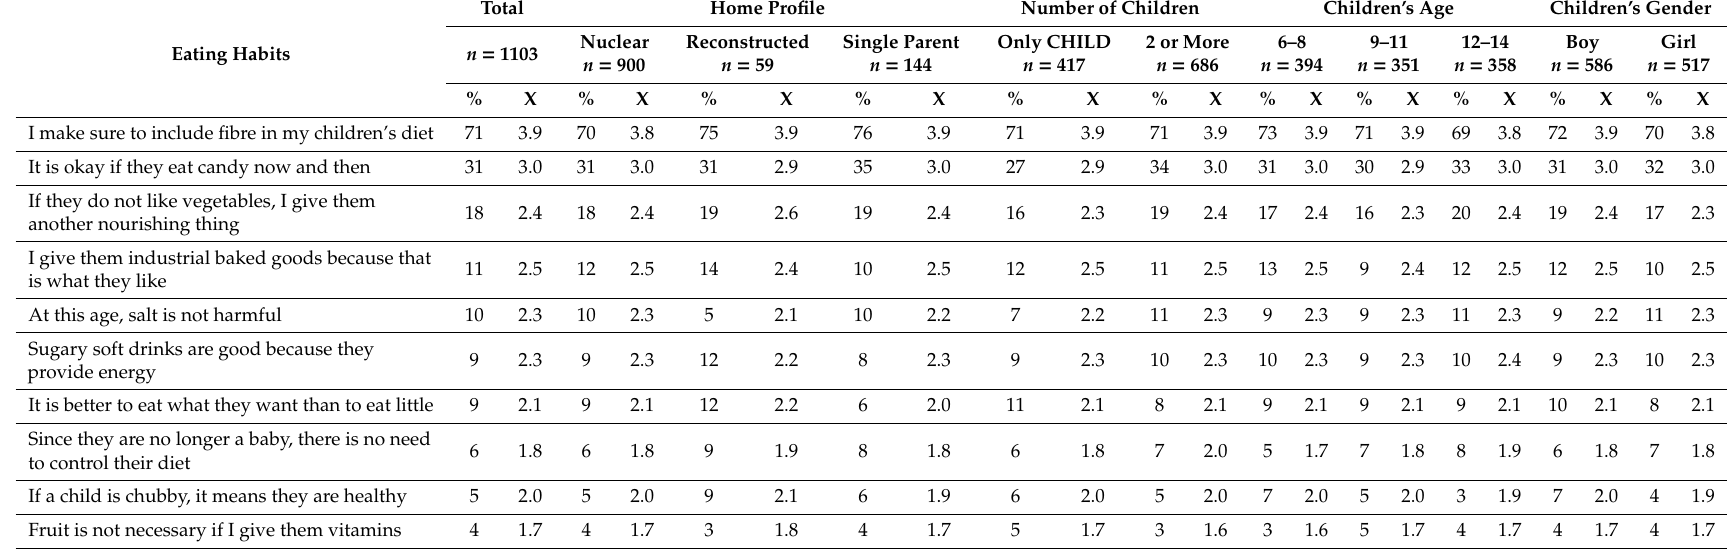
Table 3. Percentage and averages of eating habits in families with children aged 6 to 14 according to household profile (nuclear, reconstituted, single parent), number of children, their age and their